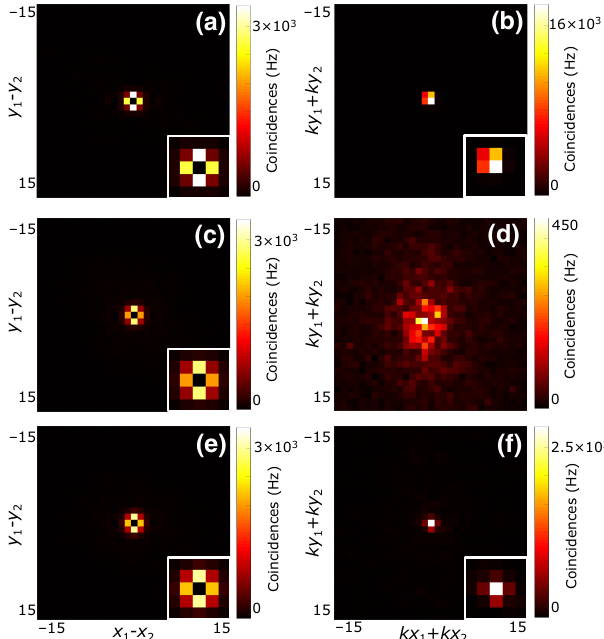
FIG. 2. Violation of the EPR criterion. Images of JPD minus- coordinate projections acquired using the position-basis configu- ration (a) without the scattering medium, (c) with the medium and no SLM correction, and (e) with the medium and SLM correction. Images of JPD sum-coordinate projections acquired using the momentum-basis configuration (b) without the scatter- ing medium, (d) with the medium and no SLM correction, and (f) with the medium and SLM correction. Analysis is performed on a total of 1.5 × 10 9 images. The central pixel in the minus- coordinate projections is set to zero because the SPAD camera does not resolve the number of photons and therefore cannot measure photon coincidences at the same pixel. The spatial units are in